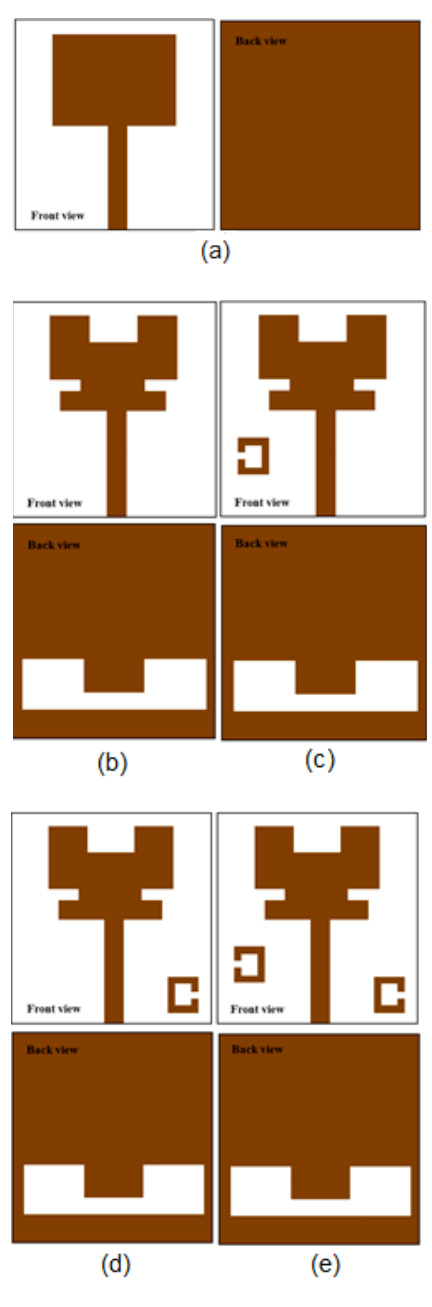
for various PE1 and PE2 11